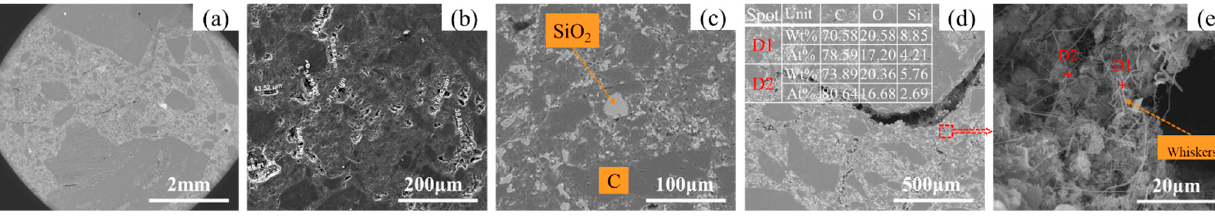
Figure 11. ( a – h ) Microscopic morphology of A after corrosion. The bottom surface of A immersed in molten iron after corrosion is presented in Fig- ure 11e,f. The reaction interface retains a good iron infiltration phenomenon. This not only adheres to small iron beads but also an iron infiltration layer in the carbon aggregates. The whole iron infiltration layer is between 30 μ m and 120 μ m, and the thinner thickness of the carbon matrix and ceramic is discovered due to the ceramic presence. It is strong proof that the ceramic material enhances the carbon brick’s resistance to molten iron corrosion and penetration. From Figure 11f, it is found that the small pieces of carbon aggregates have been almost separated by iron infiltration from the carbon matrix; a nebula-like, ex- foliated, and dissolved iron–carbon mixture emerges, with 8.92% iron and 56.78% carbon in atomic ratio. The internal whiskers in the pores close to the reaction interface have been dissolved by molten iron, and the inner surface of the pores is covered by small, dense pits as ana- lyzed from Figure 11g, while a large number of whiskers still exist in the pores away from the reaction interface as shown in Figure 11h. This illustrates that the whiskers in the pores are firstly dissolved by the molten iron, thereby retarding the process of carbon brick be- ing corroded by the molten iron. The microscopic morphology of B after corrosion is presented in Figure 12. From Fig- ure 12a, an obvious arc is observed at the three-phase interface. Compared with the A corrosion morphology, the reaction interface of B is relatively flat and there are fewer iron